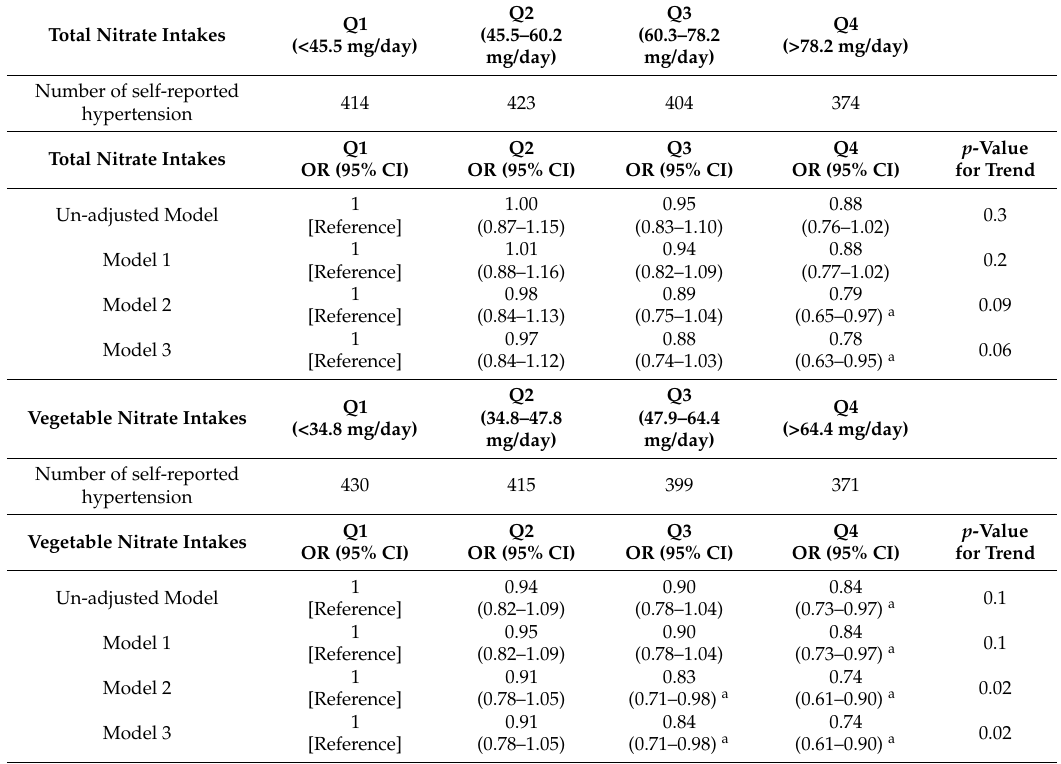
Table A3. Odds of self-reported hypertension (sensitivity analysis) by quartile of nitrate intakes in the 1946–1951 cohort of the ALSWH